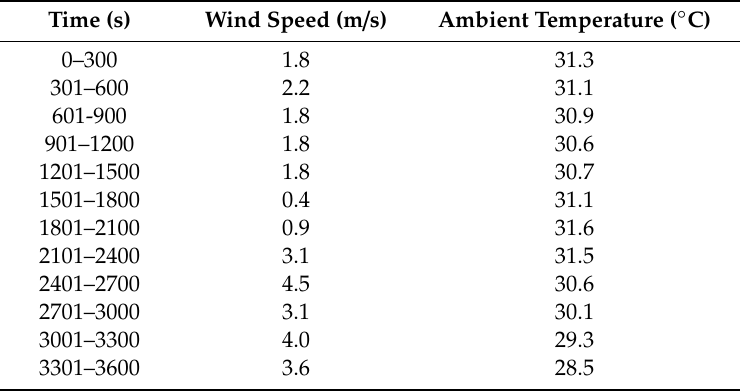
Table 7. Meteorological data around the line in one hour.